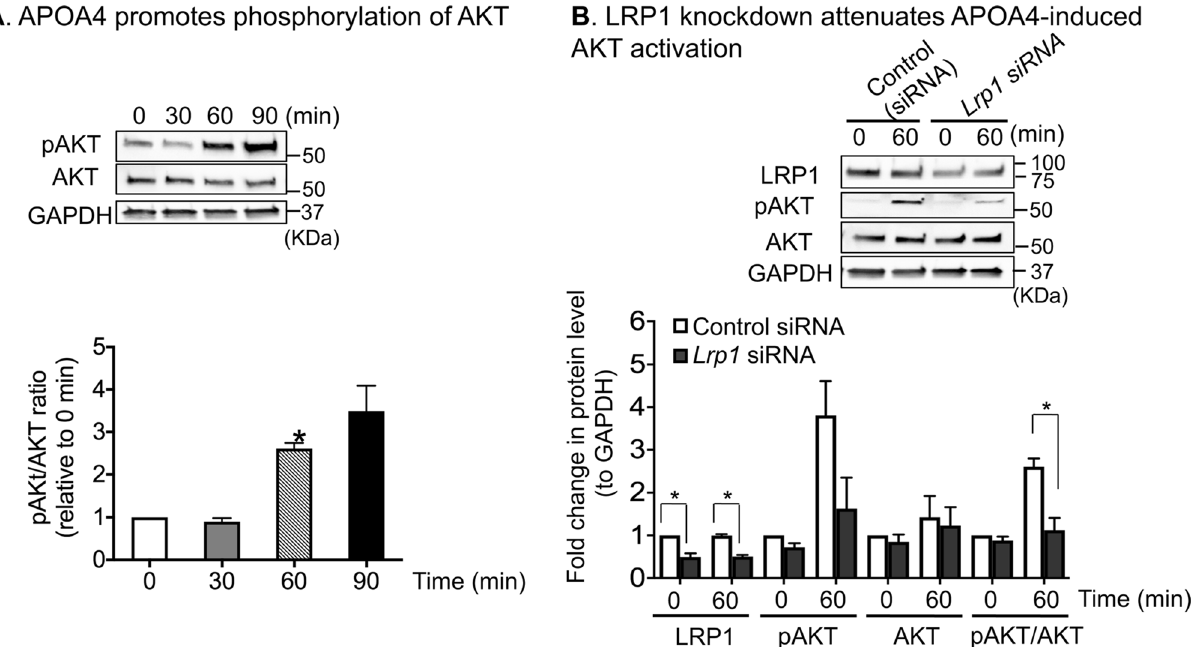
Figure 5. APOA4 activation of PI3K-AKT pathway is partly LRP1-dependent. ( A ) APOA4 promoted phosphorylation of AKT (pAKT) in a time-dependent manner. Representative western blot images are shown. After transfer of proteins, the membranes were cut into three sections before probing with specific antibodies for western blots. The top section (> 75kD) was used for LRP1 detection, the middle sections (50–75 kD) for pAKT and total AKT detection, and the bottom sections (25–50 kD) for GAPDH detection. This was necessary as stripping and re-probing compromises quantification and running separate gels would not allow for quantification. Bar graphs depicting normalized pAKT and AKT levels to GAPDH. Compared to 0 min, the pAKT/AKT ratio was significantly increased by 2.6-fold at 60 min. ( B ) Representative western blot images showing LRP1, pAKT, AKT, and GAPDH. After pAKT detection, the blot was stripped and used for detecting total AKT. At 60 min post APOA4 treatment, when LRP1 levels were reduced by ~ 50% compared with controls, the pAKT/AKT ratio decreased by ~ 58%, suggesting that APOA4-stimulated increases in pAKT are in part, LRP1-dependent (n =